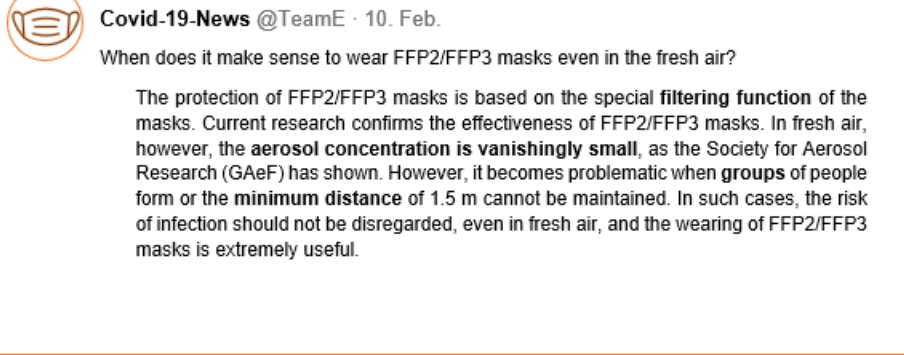
Figure A3. Scientific Posting Team D. Note. Predictor media content: scientific Posting Team D. Orig- inally presented in German. Translation: “Wie sicher ist das Wiederverwenden von FFP2/FFP3- Masken? Die Wiederverwendung von FFP2/FFP3-Masken im Alltag ist aus mehreren Gründen sinnvoll. Zum einen ist die Erregerbelastung im alltäglichen Gebrauch bei einer kurzen Tragedauer (z.B. Einkauf oder Nuten des ÖPNVs) im Vergleich zum Nutzen von FFP2/FFP3-Masken im Gesundheitswesen sehr gering . Außerdem reduziert die Wiederverwendung die Müllproduktion und damit die Umweltbelastung. Bei der Wiederverwendung von FFP2/FFP3-Masken kommt es ganz darauf an, ob die Masken nach dem Tragen richtig getrocknet werden und dadurch die SARS- CoV-2-Erreger inaktiviert und reduziert werden. Welche Methoden sich im Vergleich zu dem